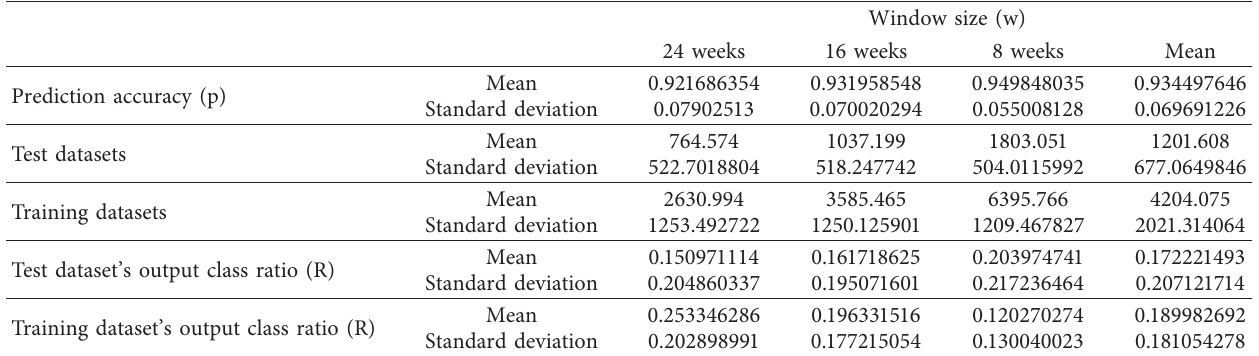
Table 1: Aggregated statistics of all 3000 iterations containing the performance summaries.